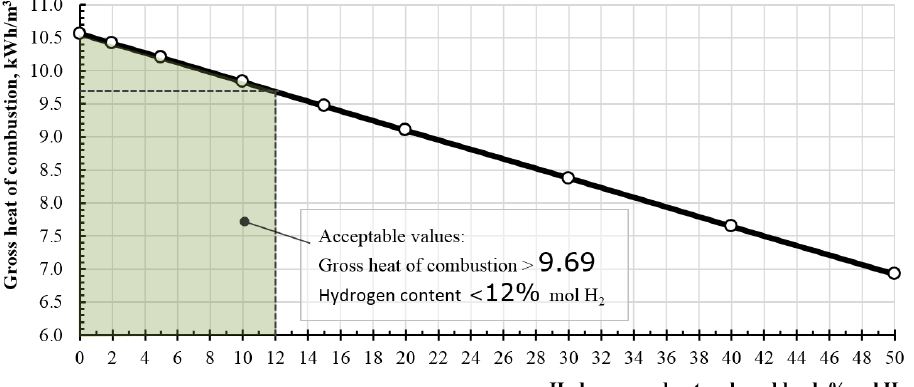
Fig. 1. Gross heat of combustion based on hydrogen